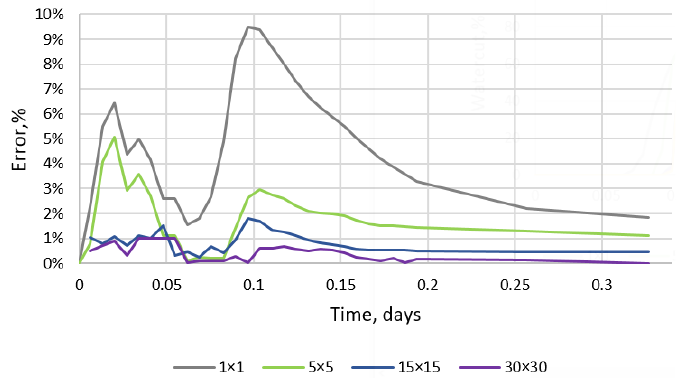
Figure 11. Comparison of the water-cut schedule for models with different meshes.